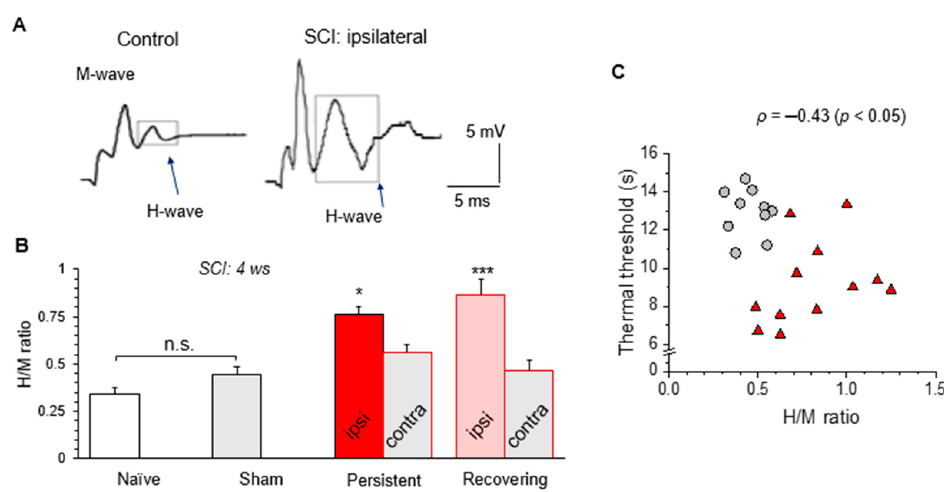
Figure 7. Acute H-reflex recordings show an impaired sensory-motor integration in all injured rats. ( A ) Examples of the H-reflex recorded on the ipsilateral to injury side in control and injured animals at 5 weeks post-operatively. Box denotes the H-wave. ( B ) Summary of the H/M ratio in experimental groups (n = 11 naïve and n = 8 sham-operated animals; n = 18 injured animals those 6 were of the ‘persistent’ group and 12 of the ‘recovering’ group. Data are mean ± SEM. * p < 0.05, *** p < 0.001 (ANOVA with Tukey post-hoc test). ( C ) The H/M ratio calculated for individual SCI rats was plotted against the corresponding thermal nociceptive threshold. The Spearman correlation coefficient ( ρ ) is indicated.